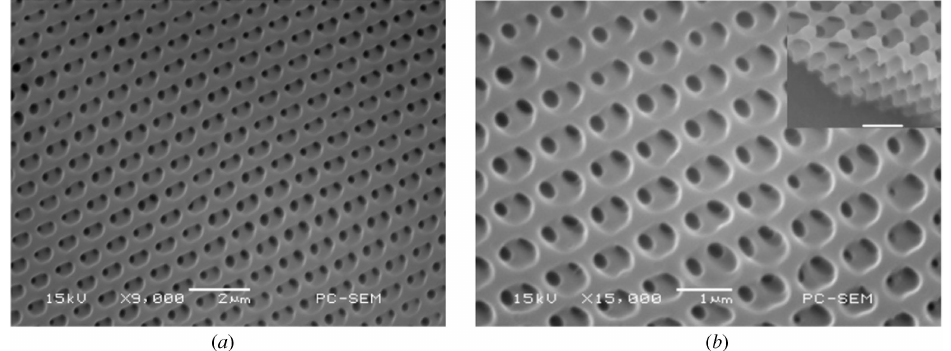
Figure 13. SEM images of 3D FCC photonic crystal fabricated in SU-8. Reprinted with permission from [41], copyright 2012 Institute of